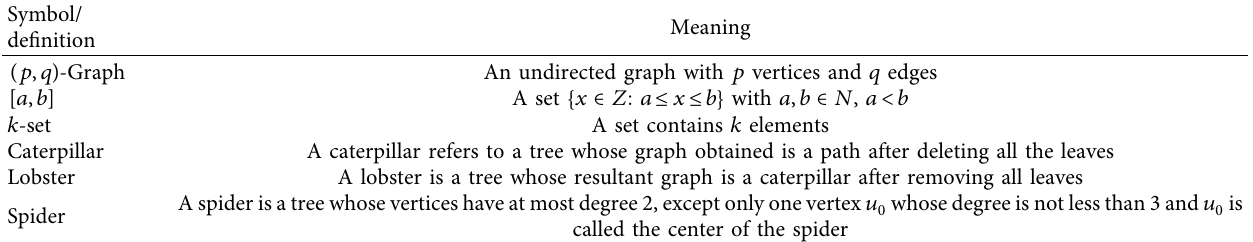
Table 1: Symbol and definition